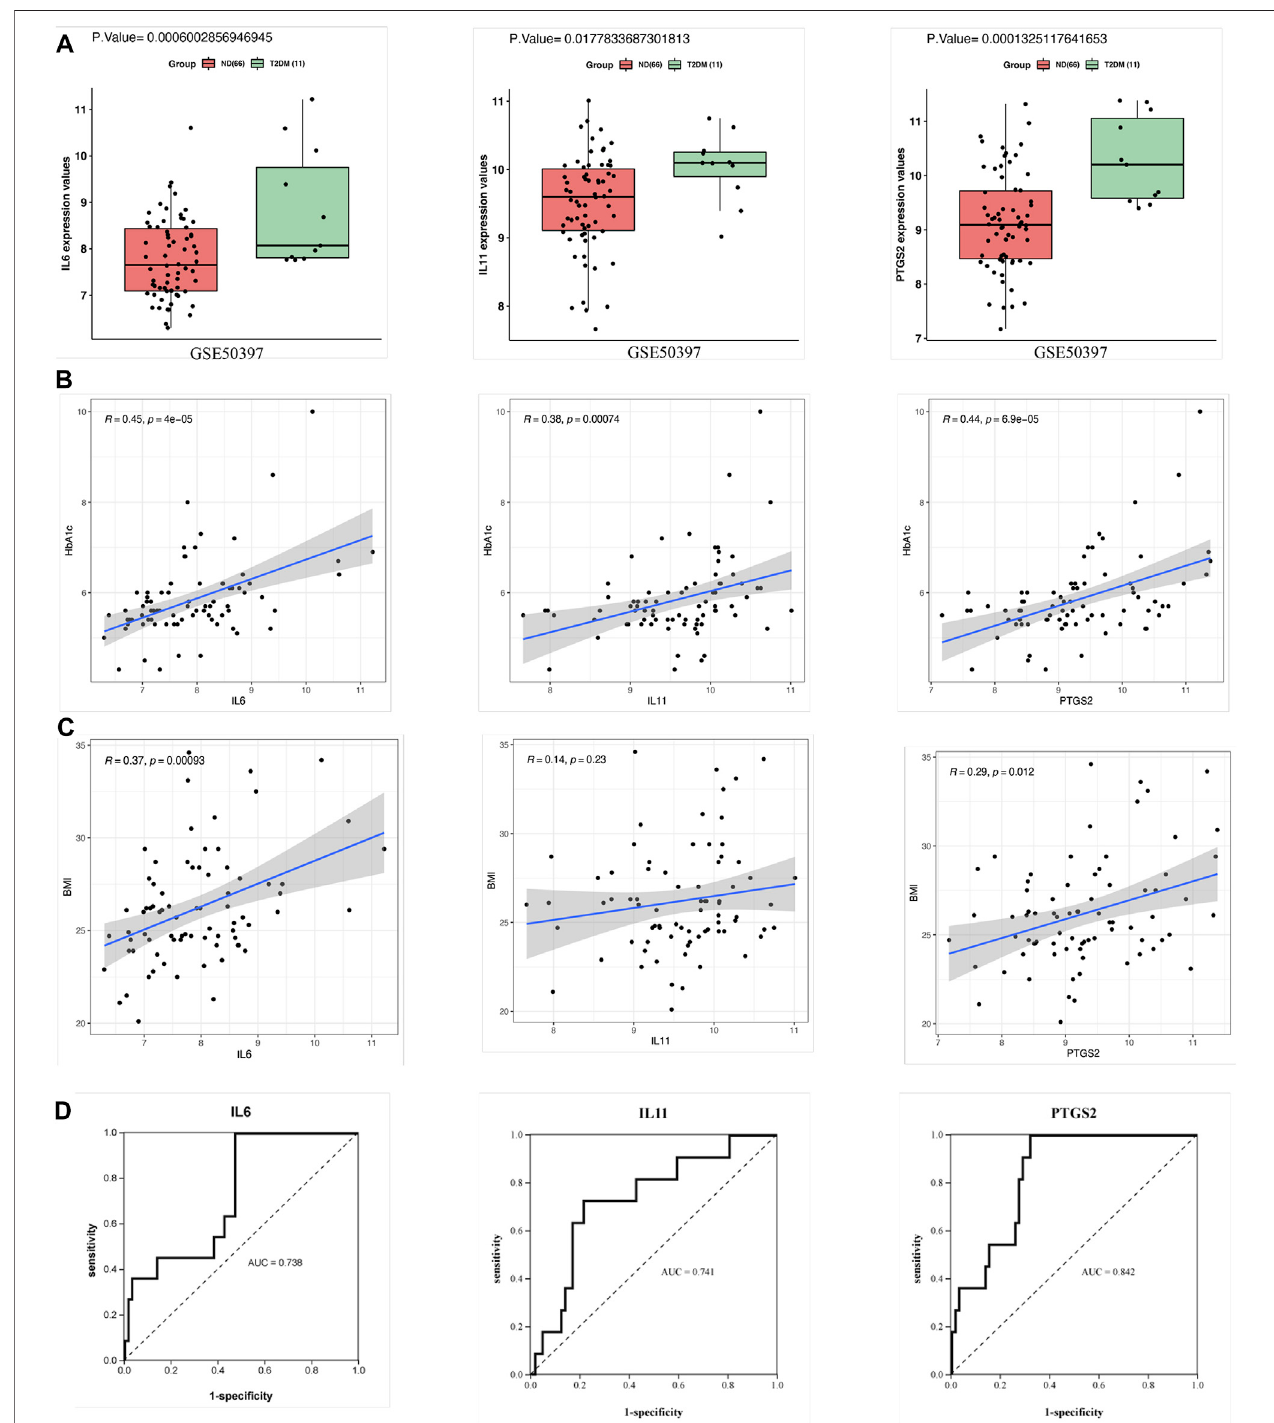
FIGURE 5| Validation ofthe hub genes in GSE50397. (A) Expression of the hub genes in human islets. The gene expression of IL6, IL11, and PTGS2 in the T2DM group was signi fi cantly greater than that in the ND group. (B) Correlation analysis between the hub genes and HbA1c. IL6, IL11, and PTGS2 all showed signi fi cant positive correlations with HbA1c. (C) Correlation analysis between the hub genes and BMI. The results showed that IL6 and PTGS2 were positively correlated with BMI butthatIL11wasnotsigni fi cantlycorrelatedwithBMI. (D) ROCcurveanalysisofthehubgenes.T-testingwasperformedtocomparethemeansofthetwogroups.